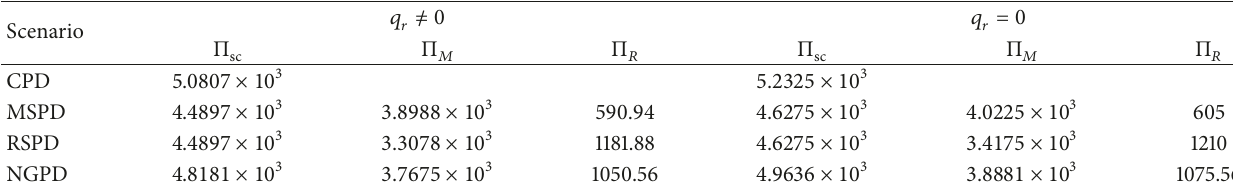
Table 2: Optimal expected profits with 𝜀 = 0.3 and 𝜃 = 0.6